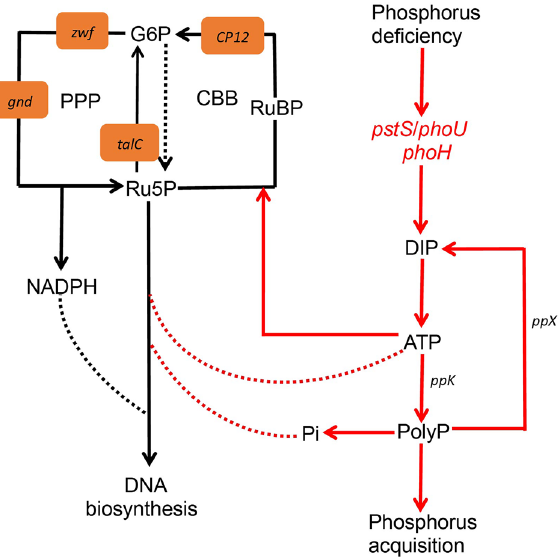
Figure 6. Biogeochemical cycling of AMGs associated with phosphorus metabolism in Napahai plateau wetland. Red line indicates the process of phosphorus